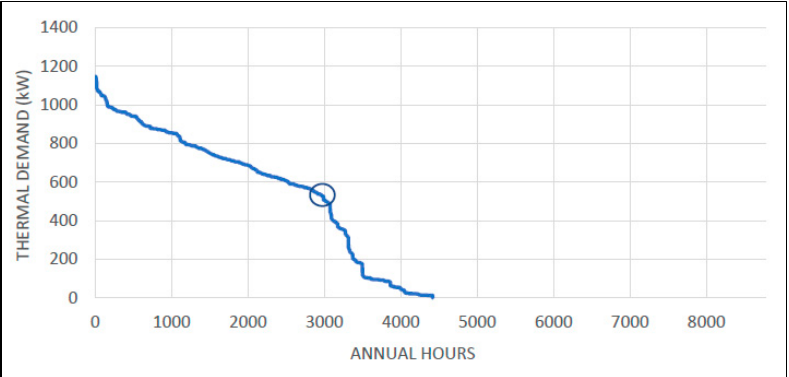
Figure 6 . Monotonic thermal demand curve: graphical representation of demand in months with heating demand.